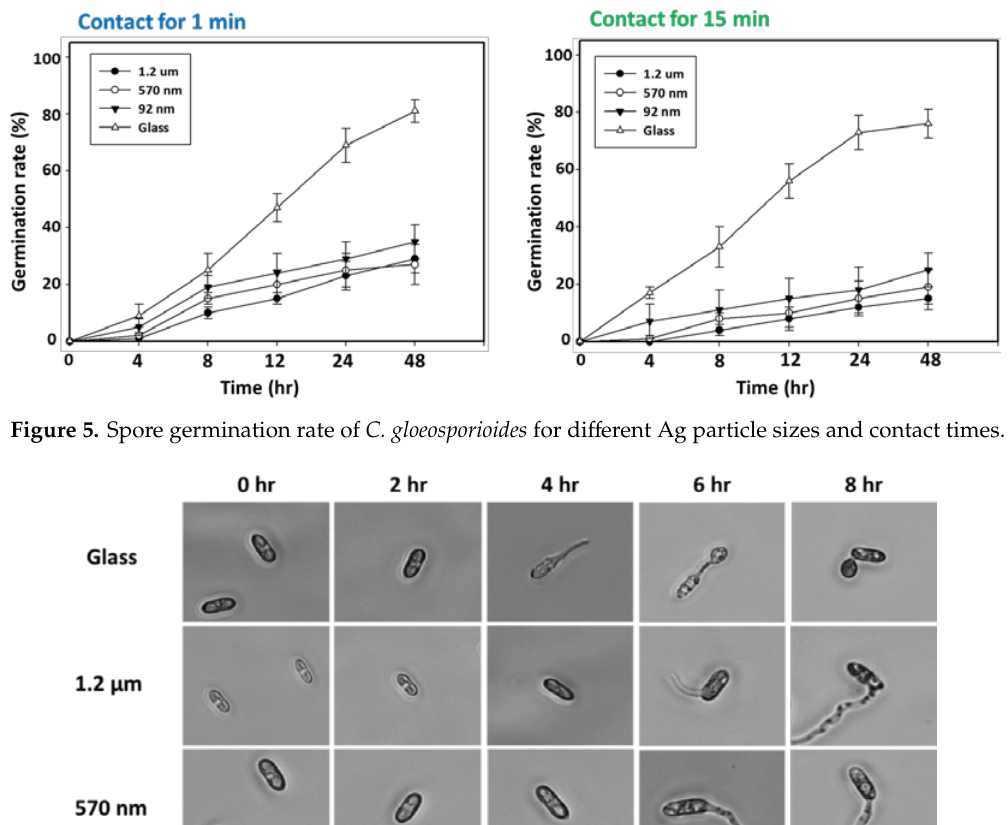
Figure 7. Morphologies of C. gloeosporioides following treatment with different Ag samples.